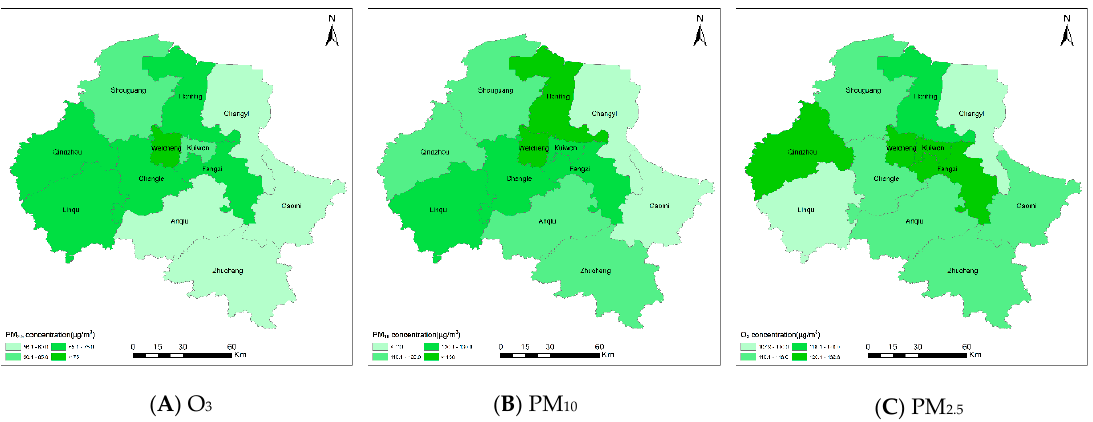
Figure 10. Spatial distribution of the primary pollutant concentrations in Weifang. ( A ) O 3 concentration; ( B ) PM 10 concentration; ( C ) PM 2.5 concentration).